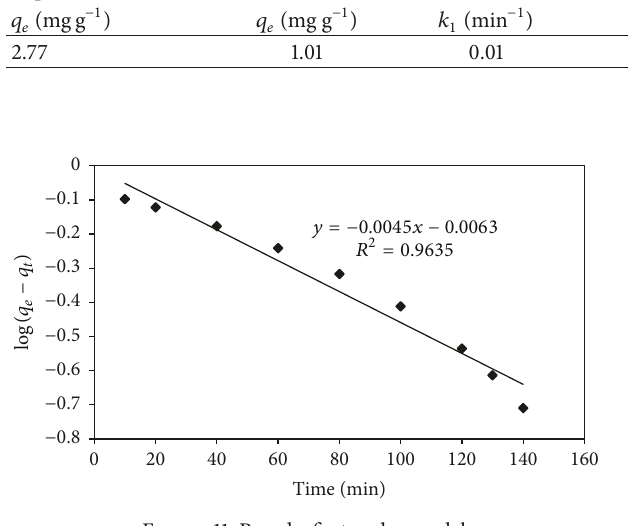
Figure 11: Pseudo-first-order model.